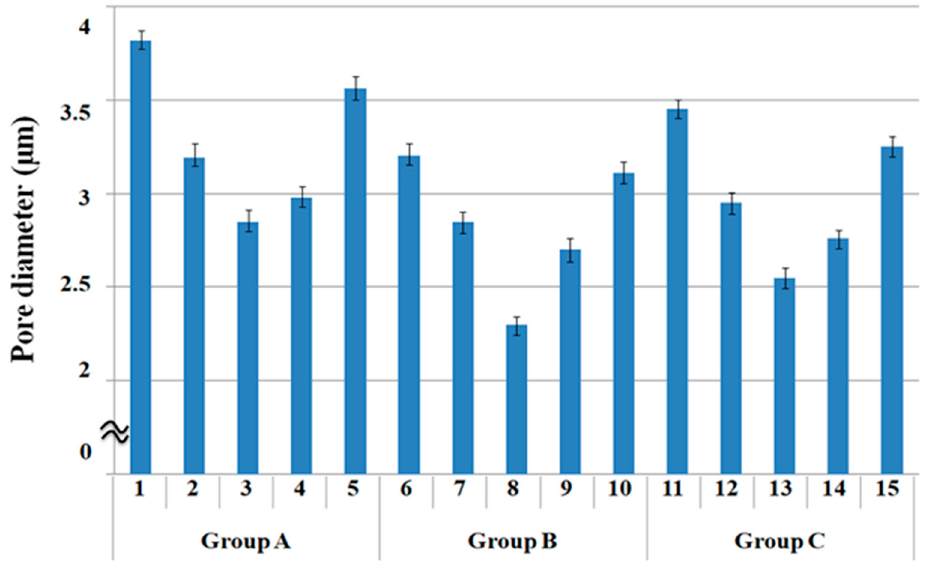
Figure 2. Pore diameters of three fabric groups ( p <